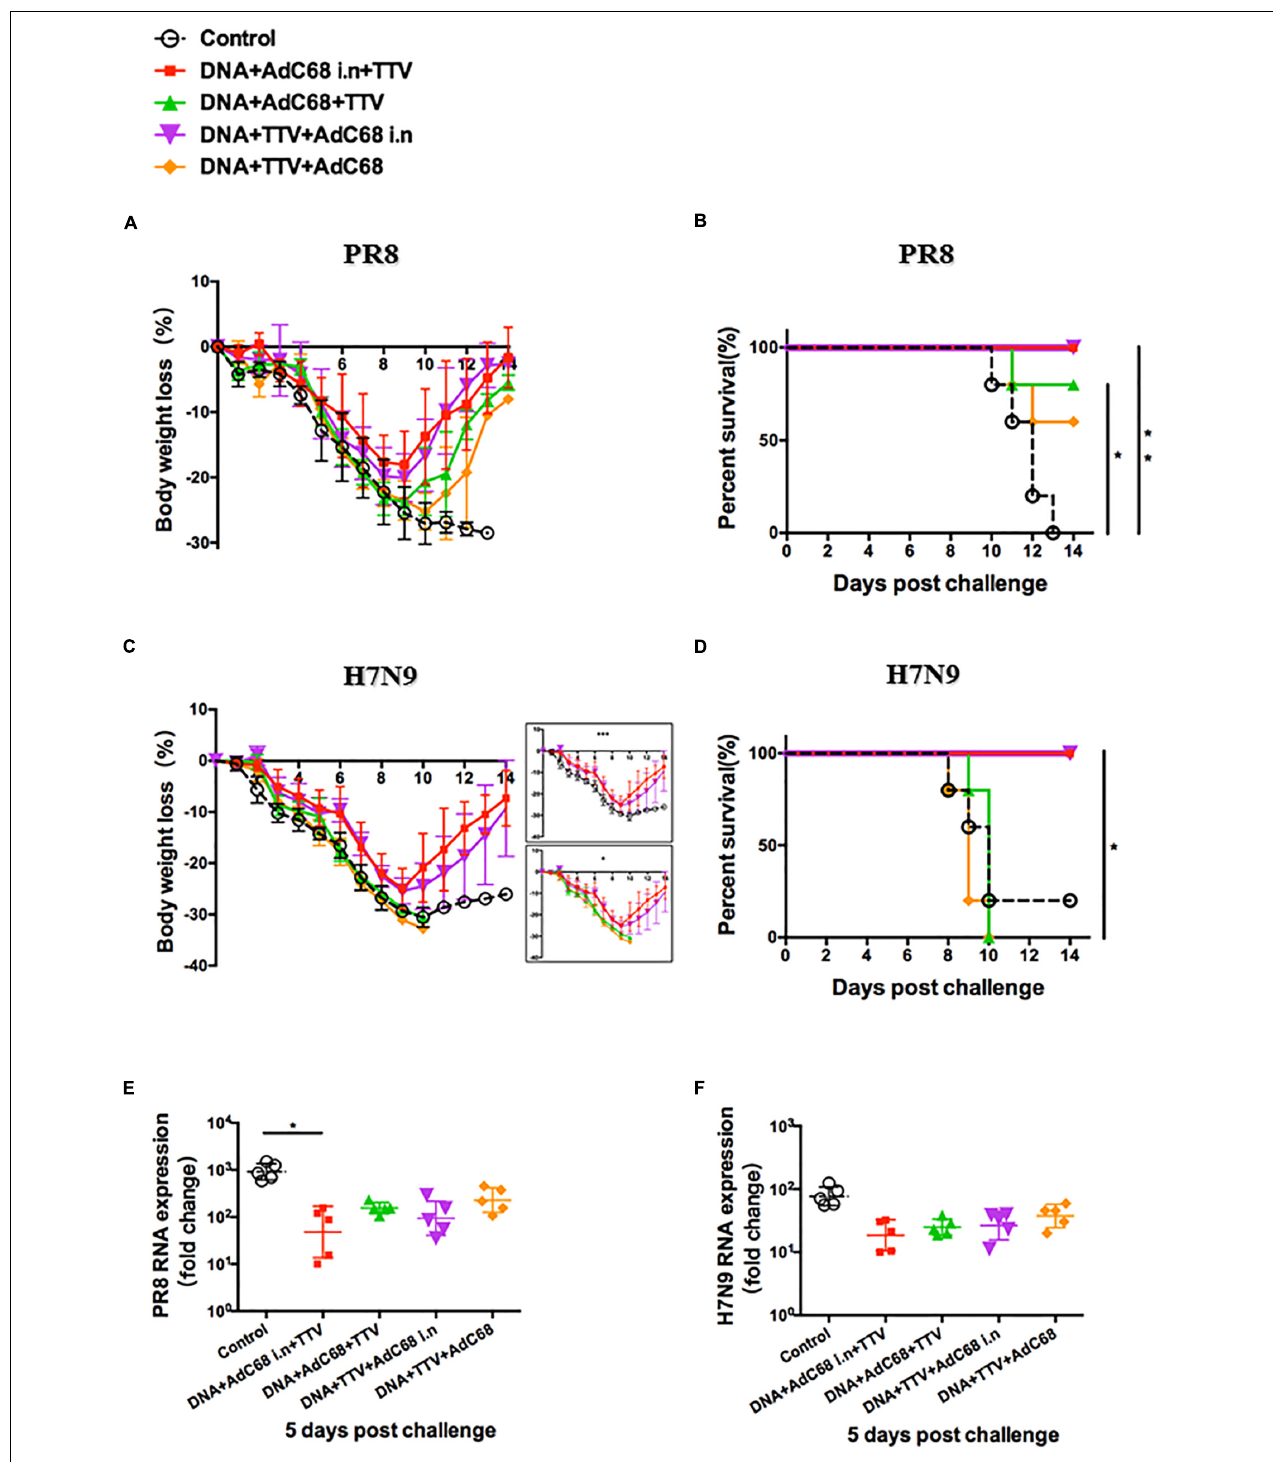
FIGURE 5 | Intranasal administration of AdC68 afforded a better protection from lethal challenge of influenza. Mice were subjected to different combinatorial immunizations following schemes outlined in Figure 4A , and 4 weeks later challenged with lethal doses of PR8 or H7N9 IAV virus. Shown are: (A,C) Body weight curves of virus-challenged mice. (B,D) Survival curve of virus-infected mice. (E,F) Relative lung viral loads at day 5 after virus challenge as measured by RT-PCR quantifications of influenza-specific RNA. The error bars represent the SDs. Two-way ANOVA test, Mantel–Cox log rank test and t -test were used to determine difference in weight loss, lethality, and viral load, respectively. ∗∗ p < 0.01; ∗ p < 0.05; n = 5. Weight loss in the two intranasal immunization groups were significantly different from both the two non-intranasal immunization groups and control group with p < 0.001 and p < 0.05, respectively.